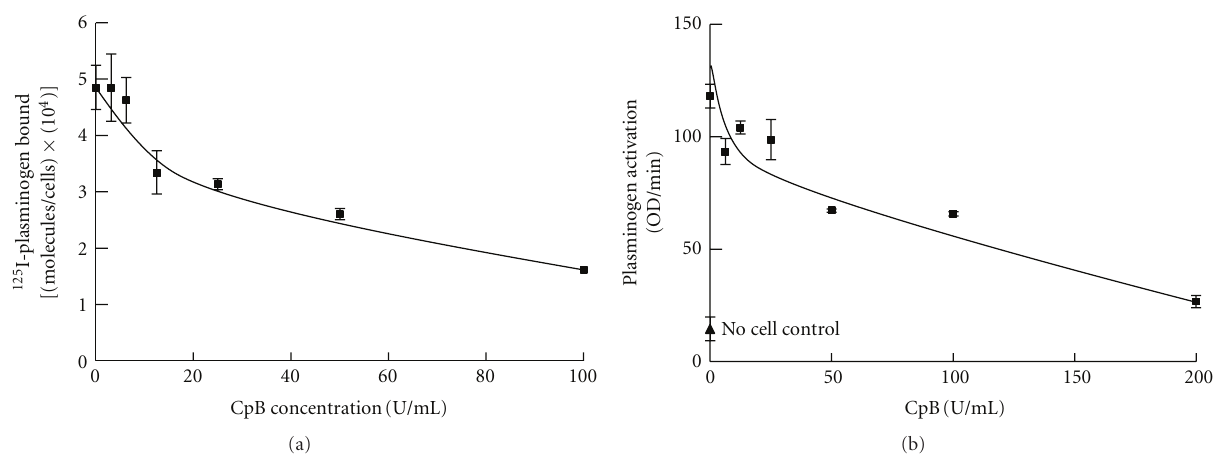
Figure 3: E ff ect of treatment of PC12 cells with CpB on the interaction with plasminogen. PC12 cells were incubated with increasing concentrations of CpB and specific binding of 0.2 μ M 125 I-plasminogen (a) and plasminogen activation (b) were assessed as described in [24].